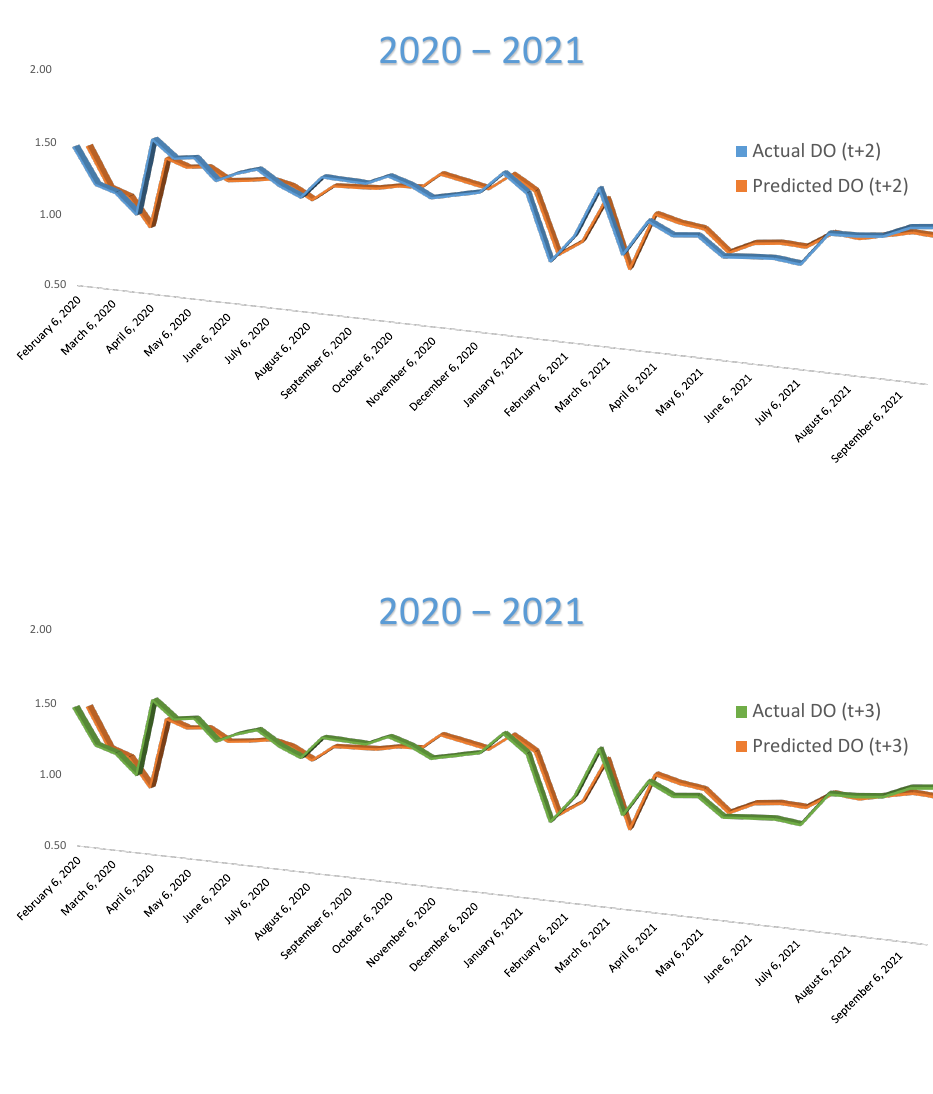
Figure 8. Test data results of the Bi–LSTM model for multi–step (t + 1, t + 2, t + 3) forecasts of the optically inactive parameter DO for the years 2020 and 2021.